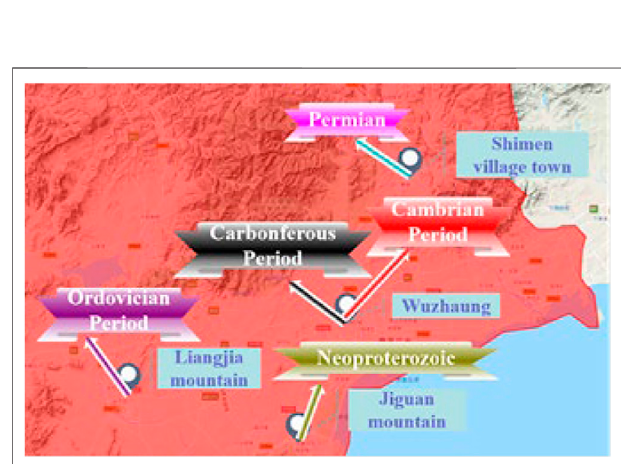
FIGURE 2 | The geographic locations of the rock samples.